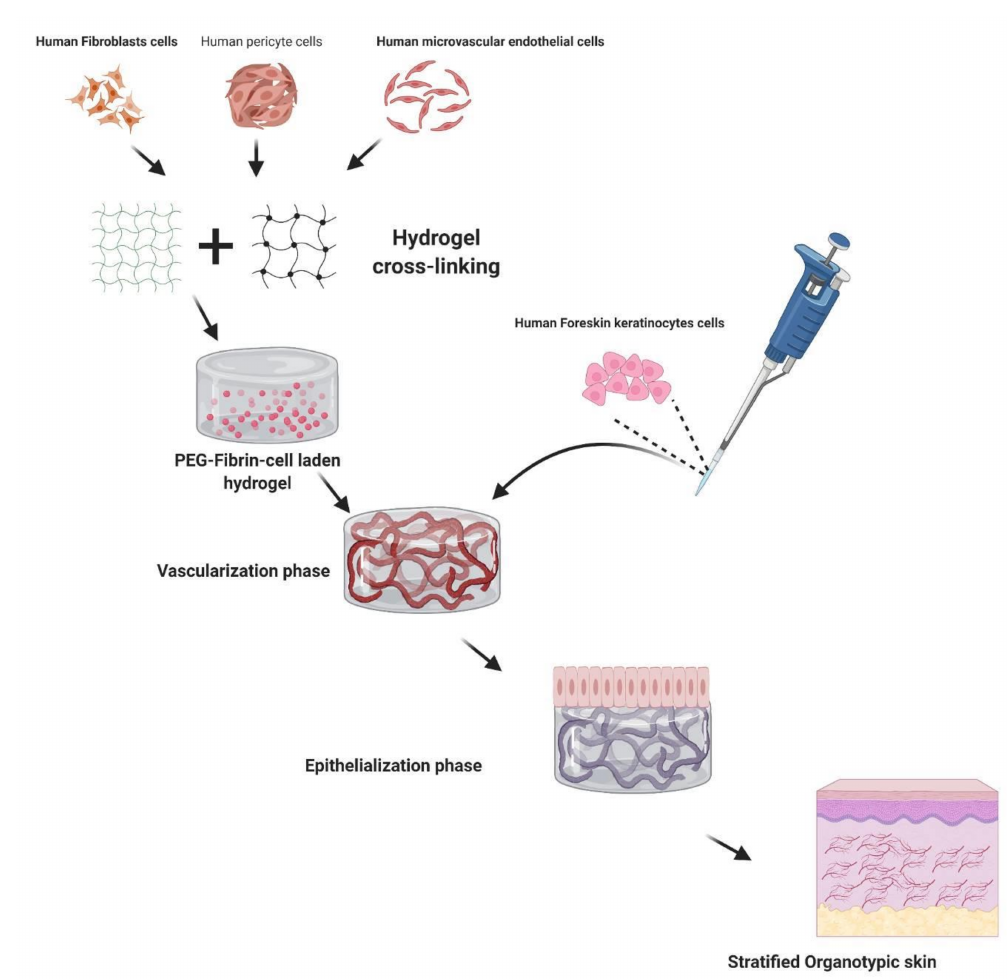
Figure 3. The schematic representation of fabricating RHS from human cells and